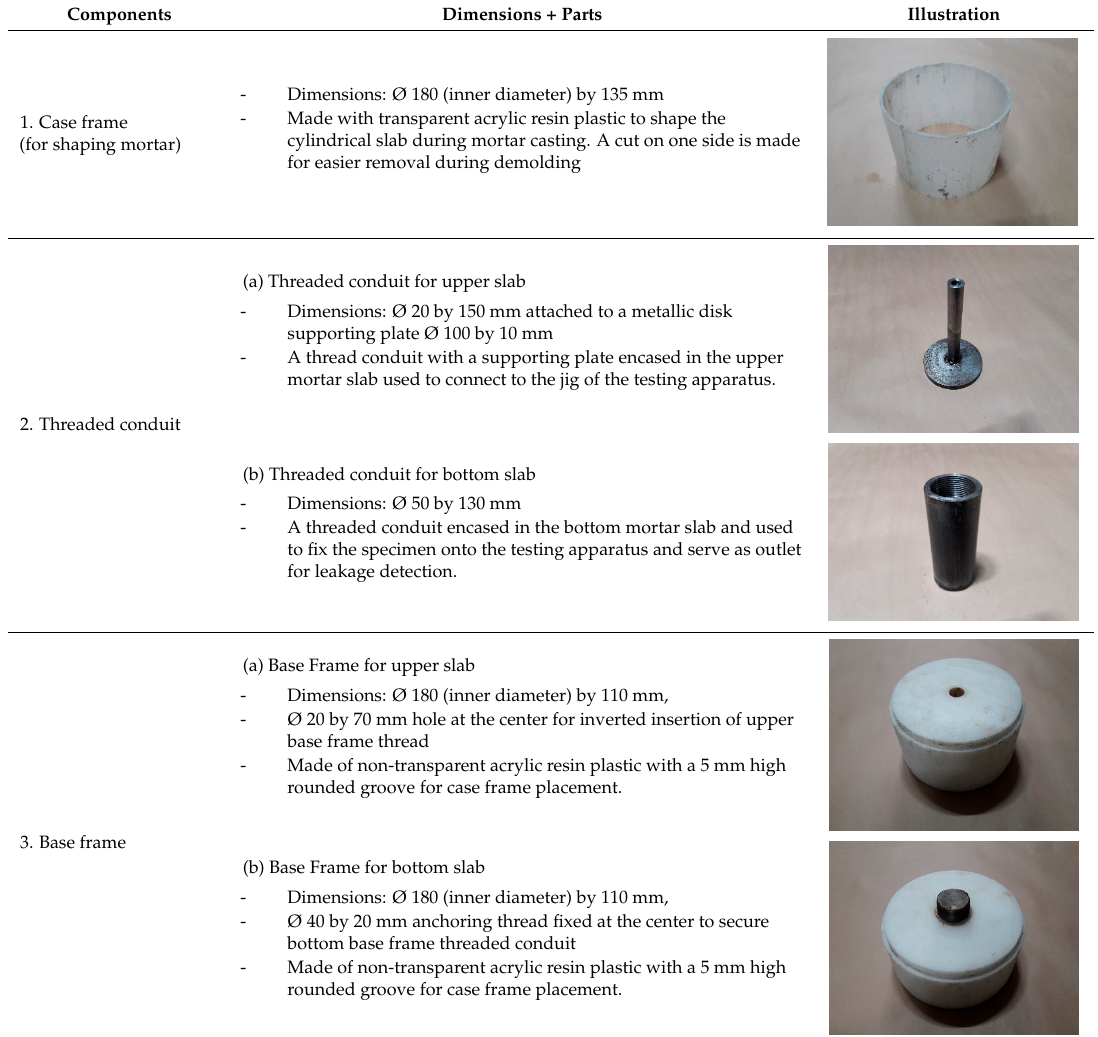
Table 9. Components and details of mold to make mortar slabs.